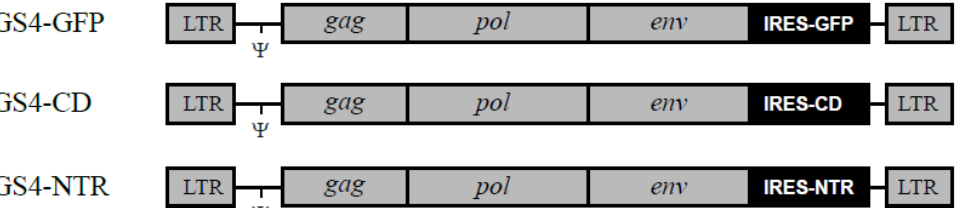
Figure 1. Structure of gibbon ape leukemia virus (GALV)-retroviral replicating vectors (RRV) carrying